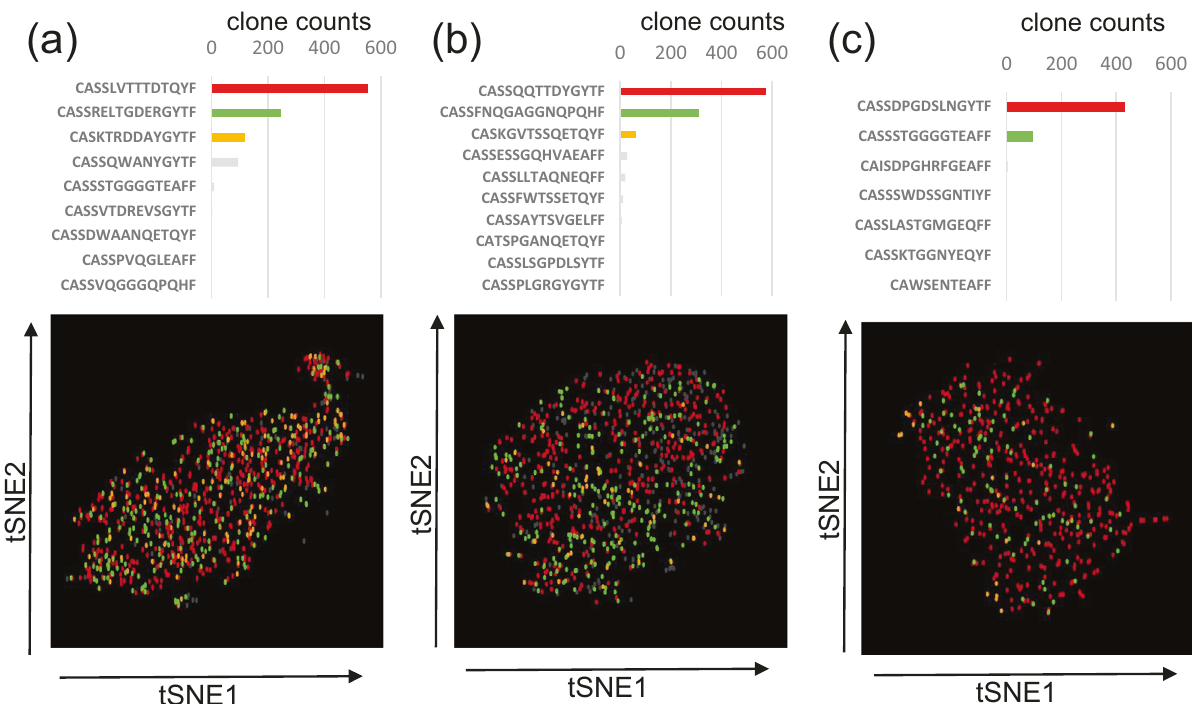
Fig. 4 Single-cell RNA-sequencing of HLA-A24-restricted CMV-pp65-speci fi c cytotoxic T-cells (CMV-CTL). CMV-CTL clone counts and t-SNE plots in a Case14, b Case4, and c Case3. The actually-analyzed cell counts with combined information on gene expression and TCR β -CDR3 were 972 (Case 14), 747 (Case 4), and 501 (Case 3) cells after apparently dying cells were deleted. Each dot represents a single cell and each color denotes the same individual clone. There was no robustly signi fi cant difference with a two-fold change and P < 0.05 in gene expression among the clones in each recipient, except for the TCR genes in all cases and GNLY and FXYD5 in Case3. The t-SNE clustering plots are shown after deleting apparently dying cells from